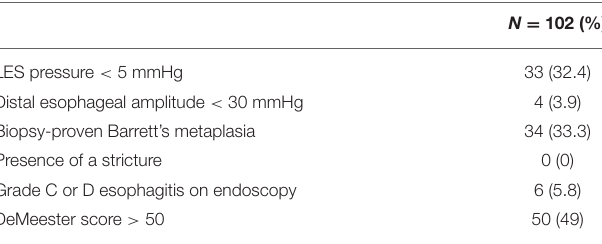
TABLE 1 | Distribution of pre-operative abnormalities in patients with severe GERD.